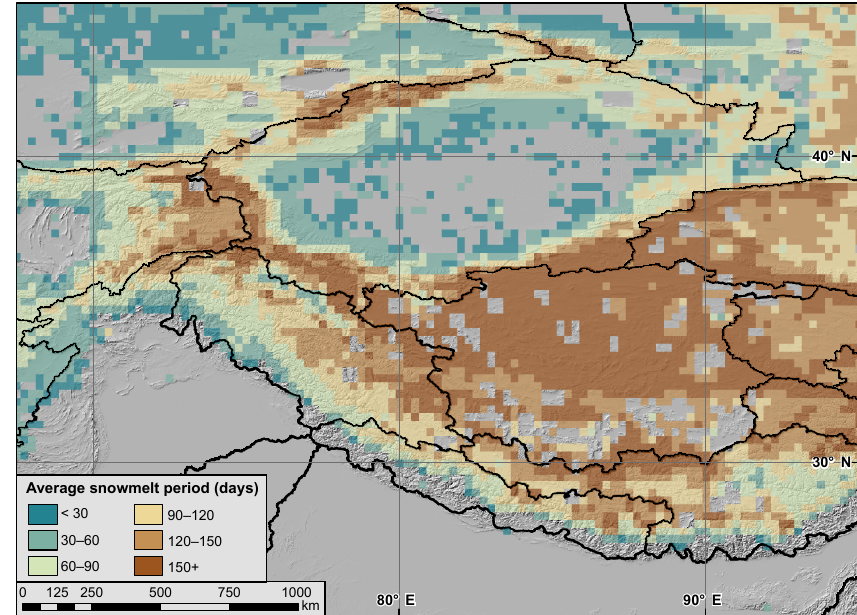
Figure 6. Average snowmelt period across HMA from 1987 to 2016. Snowmelt period ranges from less than a month to several months, depending on geographic location, elevation, and local and regional climatic conditions. Locations with long-term average snowmelt periods less than 20 days are removed. Topographic hillshade in background. Grey areas indicate water bodies, low-SWE areas, and short snowmelt- period areas that are excluded from the analysis.